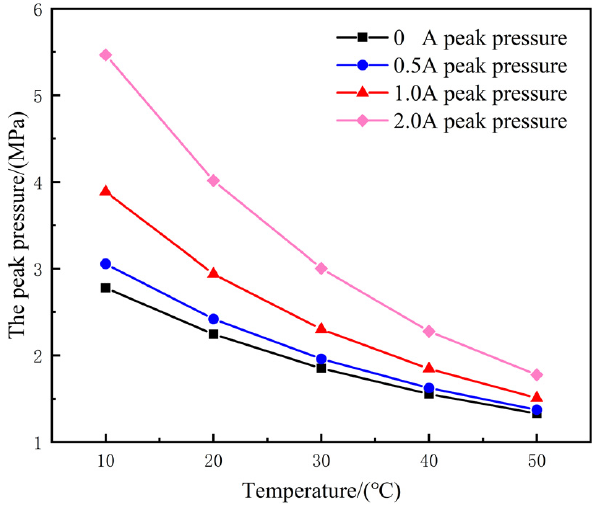
Figure 18. Effect of temperature on peak pressure under impact conditions.